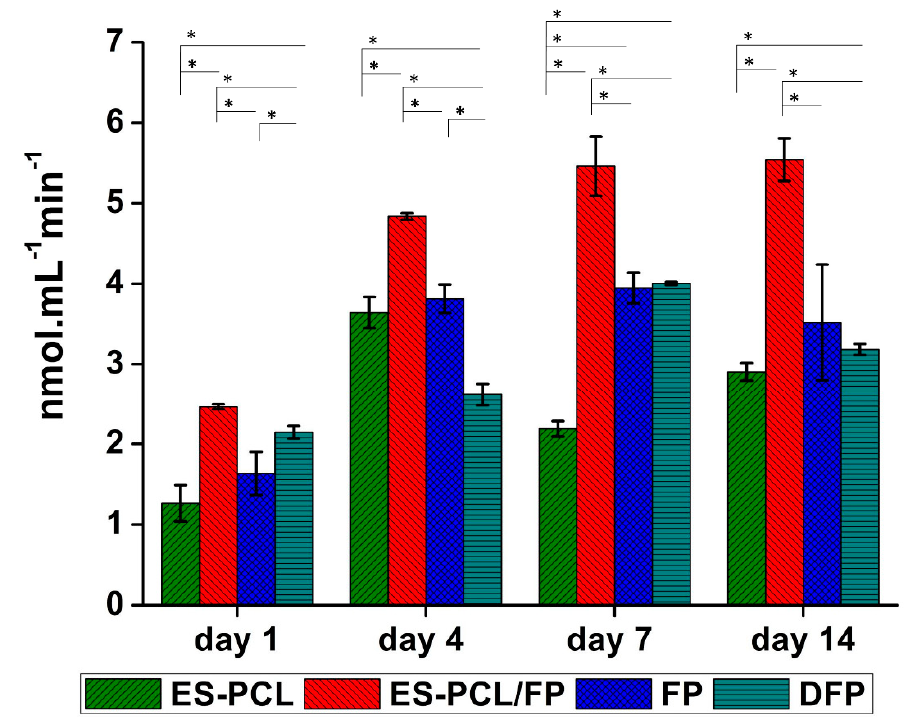
Figure 6. Bone metabolic activity analysis. Alkaline phosphatase (ALP) assay results for hFOB seeded-in (ES-PCL, ES-PCL/FP, FP, and DFP) at different time point. The ALP activity of hFOB increased on ES-PCL, ES-PCL/FP, FP, and DFP as a function of time. The results are statistically significant (P < 0.05).